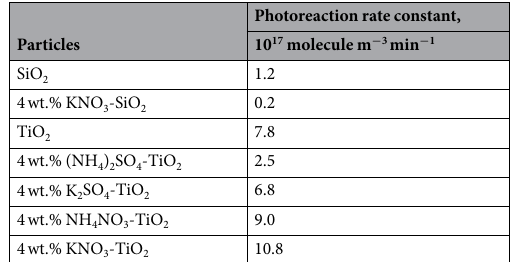
Table 1. Photoreaction rate constants of HCHO on different aerosol particles. The photolysis rate constant (1.2 × 10 17 molecule m − 3 min − 1 ) has been subtracted.